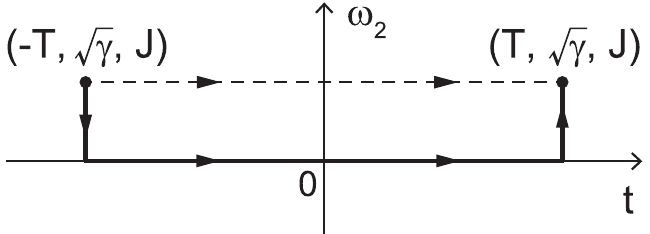
Figure 1: The original path denoted by the dashed line is deformed to the bold line. (cid:112) ω = γ is kept 1